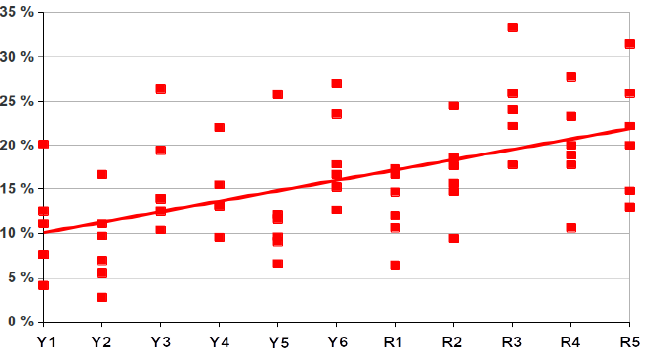
Figure 6. Trendline with data on residents (R1 to R5) and data on medical students (Y1 to Y6) of our previous study [9].